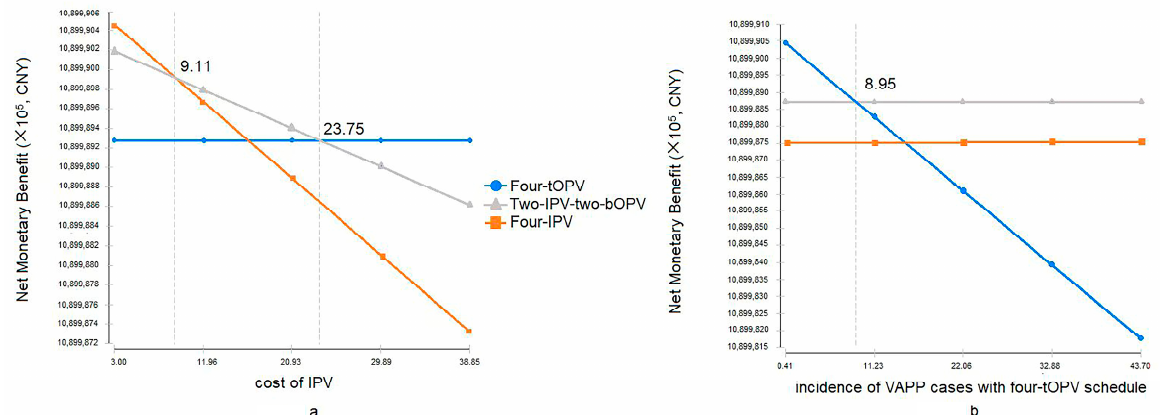
Figure 4. One-way sensitivity analysis net benefits graph for three polio immunization schedules. In ( a ), NMB of IPV-containing schedules was estimated over cost of IPV ( X -axis), while that of the four-tOPV schedule was constant. In ( b ), NMB of the four-tOPV schedule was estimated over the incidence of VAPP cases with the four-tOPV, and those of IPV-containing schedules remained stable. The WTP in the decision tree model was set as CNY 600,000. NMB = total benefit – total cost, in which total benefit = effectiveness (sum of LY per year) × bound of ICERLY (that is WTP) and total cost was the total annual cost of different polio immunization schedules. bOPV, bivalent live attenuated oral polio vaccine; tOPV, trivalent live attenuated oral polio vaccine; IPV, inactivated polio vaccine; NMB, net monetary benefit; VAPP, vaccine-associated paralytic poliomyelitis.